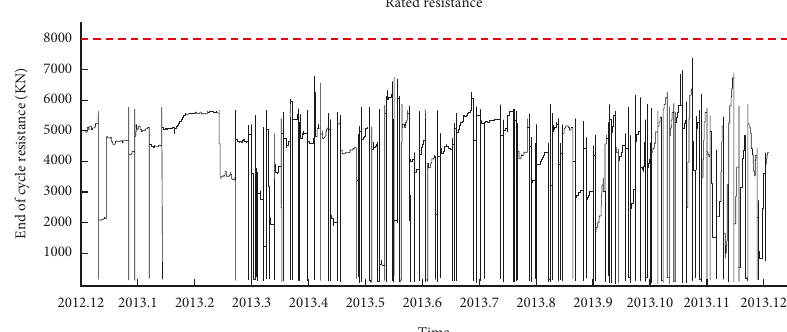
Figure 8: P-T curve of 45# hydraulic support in middle of mining face [12].